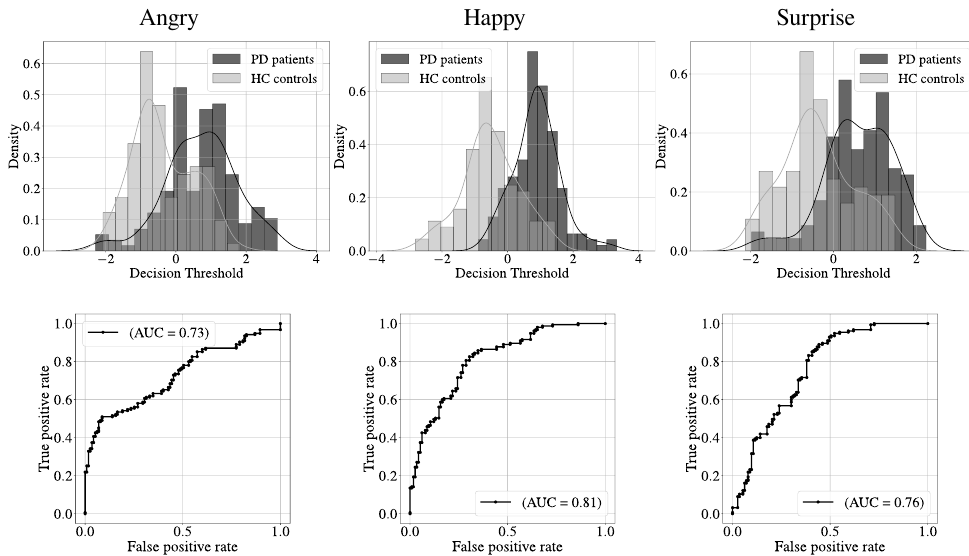
Figure 10. Score distribution ( Top ) and ROC curve ( Bottom ).